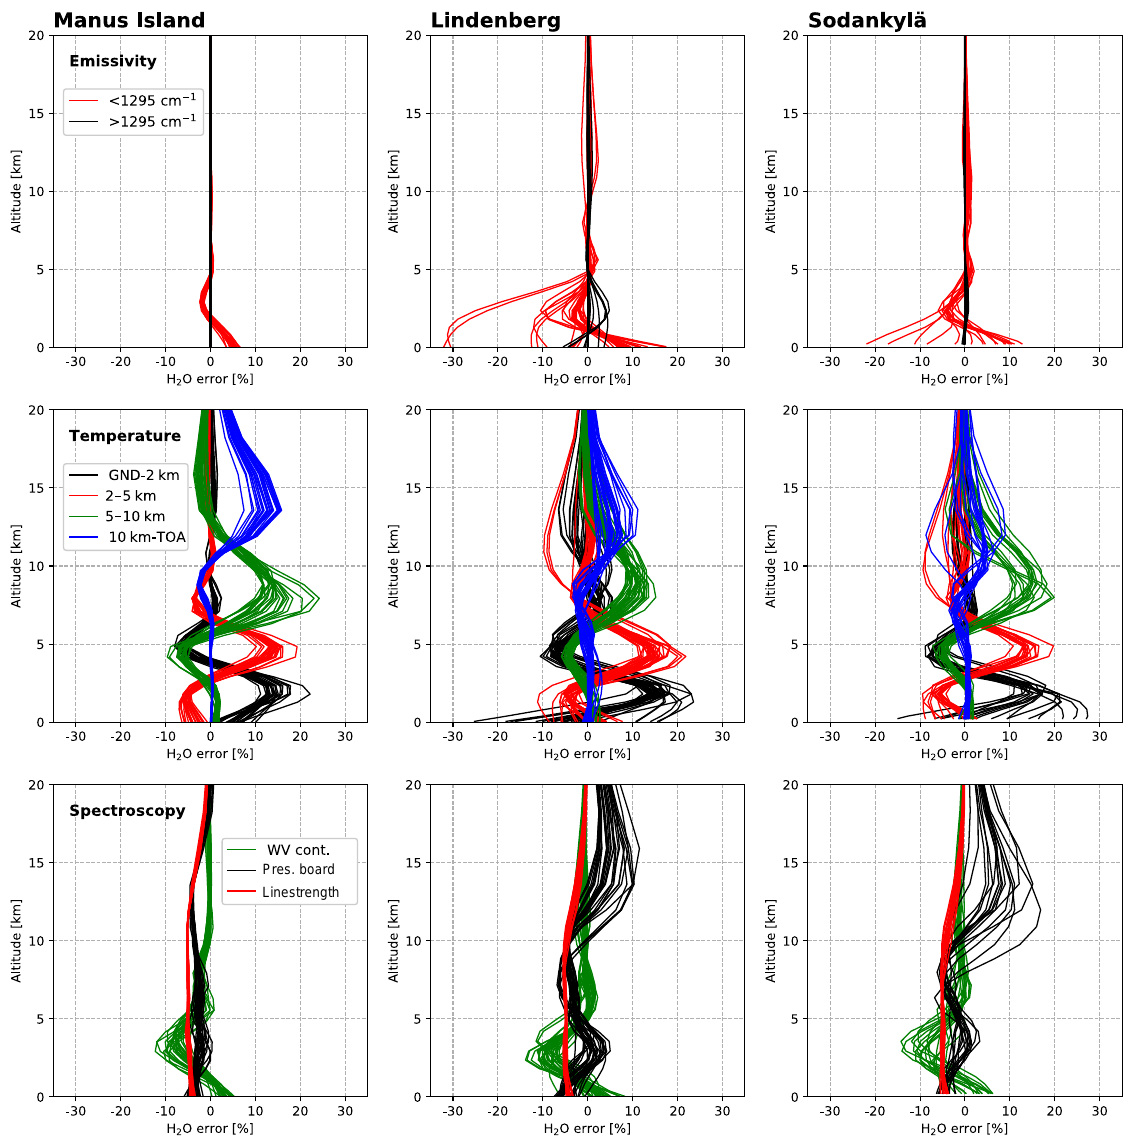
Figure 8. H 2 O error profiles derived from the systematic uncertainty sources: emissivity ( − 1% in two different wavenumber regions), atmospheric temperatures (2K between surface and 2kma.s.l. and 1K in the other layers), and spectroscopy (line strength, + 5%, and pressure-broadening, + 5%) and the water vapour continuum (assuming a 10% underestimation of the MT_CKD model). The errors in the atmospheric state vector (cid:49) ˆ x are shown according to Eq. (7). The data are depicted for all members of the MI, LI08, and SK07